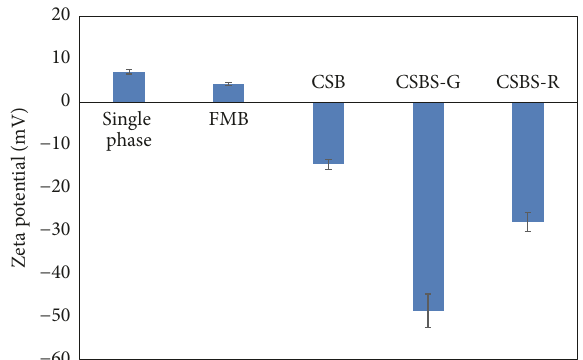
Figure5:Zetapotentialofsingle-andmultiphasesystemsmeasured in this work. Single-phase value corresponds to the zeta potential measured in the rock samples saturated with FMB (Sw=1); FMB corresponds to the zeta potential measured at the end of the secondary FMB waterflooding when the rock sample was saturated with formation brine and residual oil (Sor=0.32); CSB corresponds to the zeta potential measured at the end of CSB flooding when the rock sample was saturated with CSB and residual oil (Sor=0.23); CSBS-R corresponds to the zeta potential measured at the end of CSB combined with 1 wt.% rhamnolipid waterflooding when the rock sample was saturated with CSBS-R and residual oil (Sor=0.19); CSBS-G corresponds to the zeta potential measured at the end of CSB combined with 1 wt.% greenzyme waterflooding when the rock sample was saturated with CSB-R and residual oil (Sor=0.17). The error bars reflect the accuracy of the instrument, noise level in measured voltage, and repeatability of